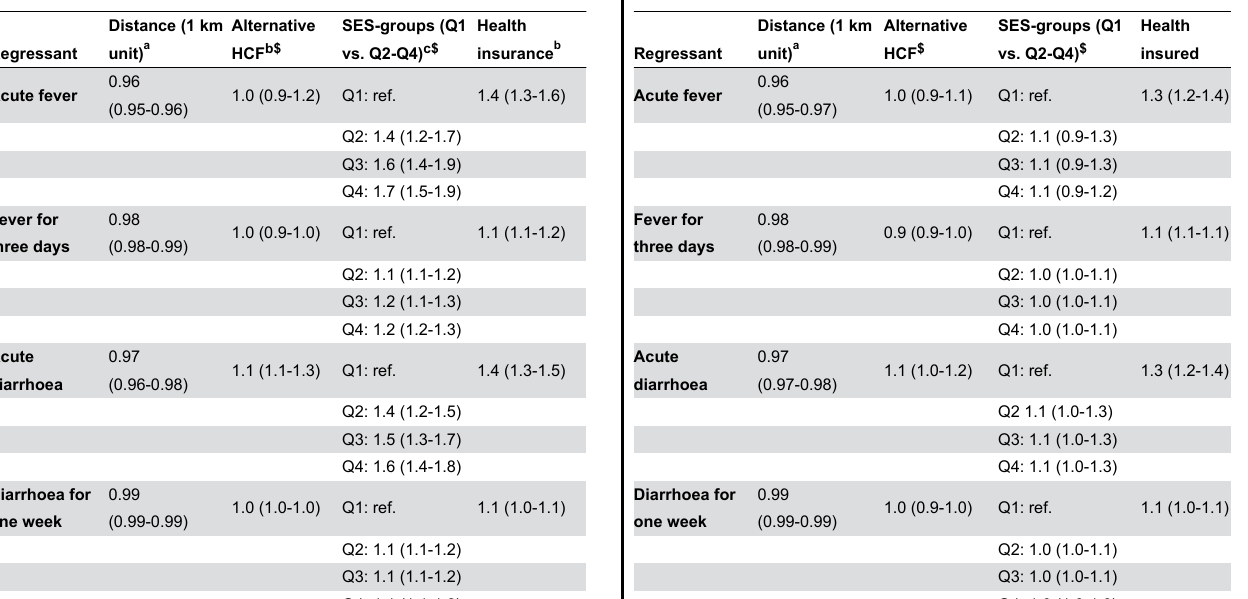
Table 3. Bivariate associations (prevalence ratios with 95%-confidence interval) between hospital attendance and explanatory variables for the different disease symptoms, Asante Akim North District, Ghana, 2008.